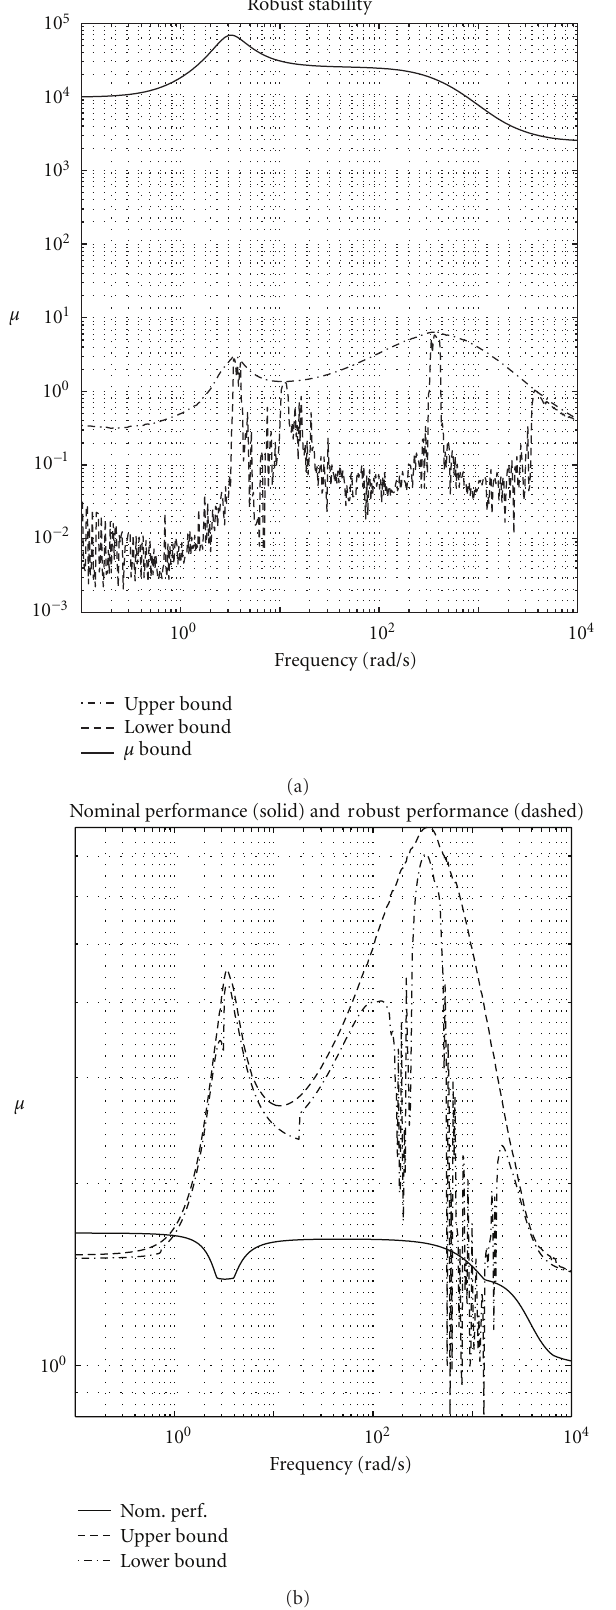
Figure 8: Robust stability, nominal and robust performance function described by μ -value with μ